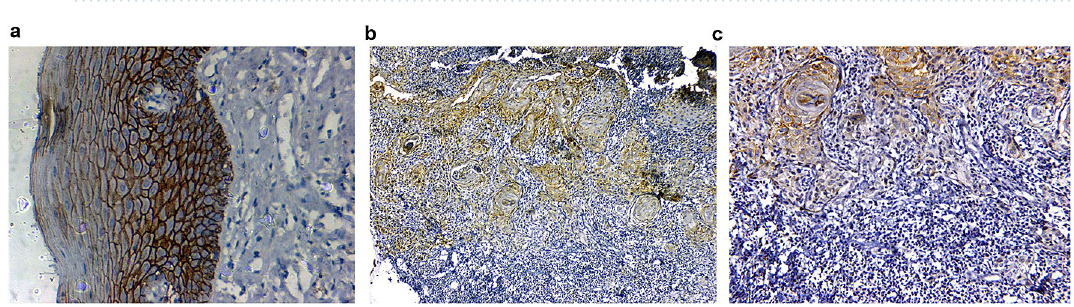
Figure 3. Immunoexpression of LAMC2: ( a ) WDSCC showing intense cytoplasmic positivity for LAMC2 10X. ( b ) WDSCC showing intense cytoplasmic positivity for LAMC2 20X. ( c ) MDSCC showing intense positivity for basement membrane, but cytoplasm in negative for LAMC2, 20X.